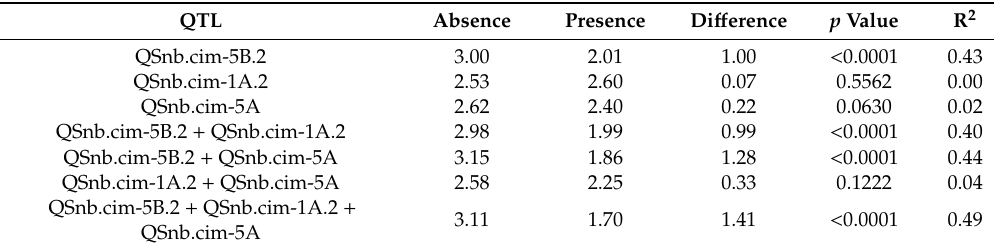
Table 6. Comparison of RILs having di ff erent Septoria nodorum blotch